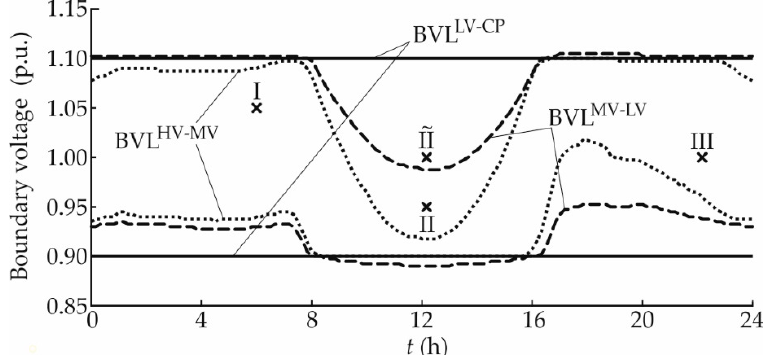
Figure 9. Voltage limits at the LV − CP (rural residential CP_Link-Grid), MV − LV (rural LV_Link-Grid), and HV − MV boundaries when no Volt/var control is applied.